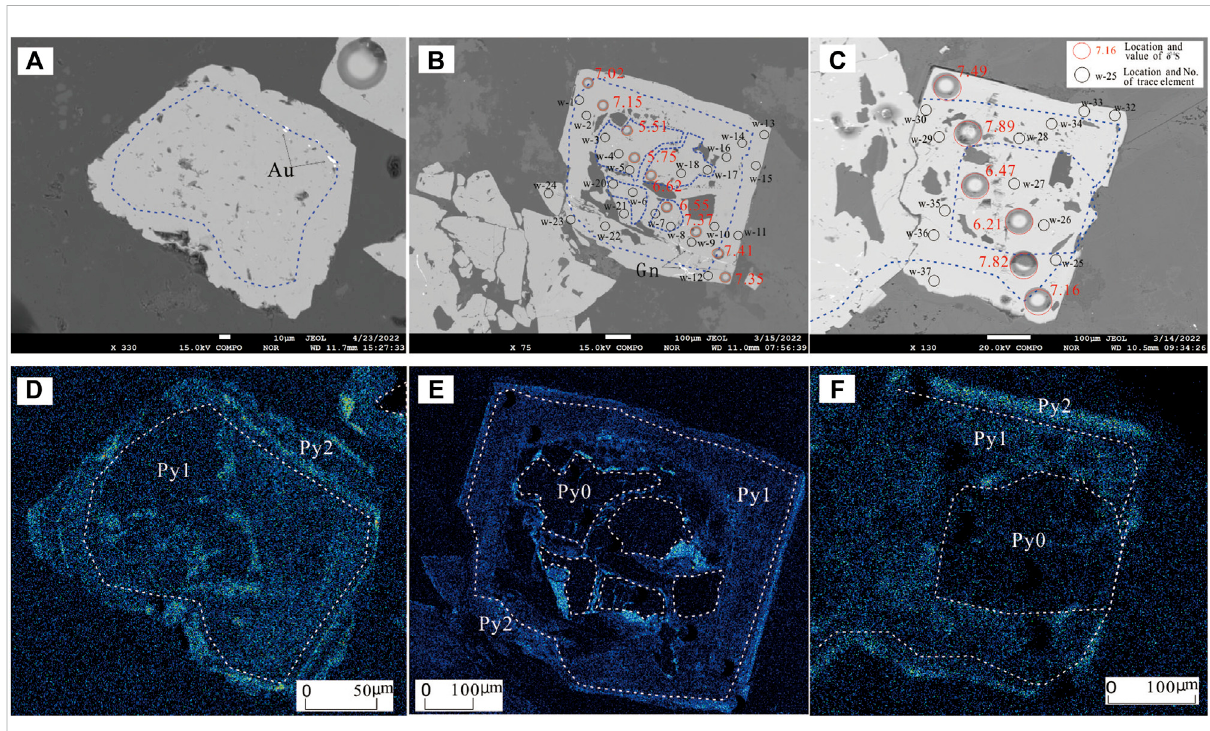
FIGURE 7 Backscattered electron (BSE) images (A − C) and element mapping images (D − F) of pyrites in the Houge ’ zhuang gold